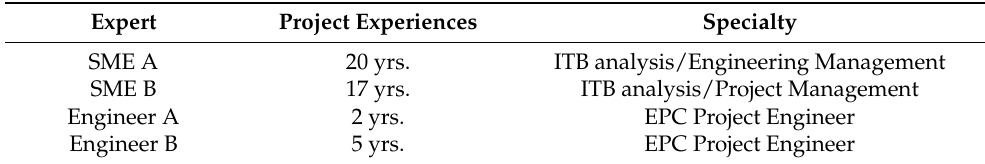
Table 6. Information of verification